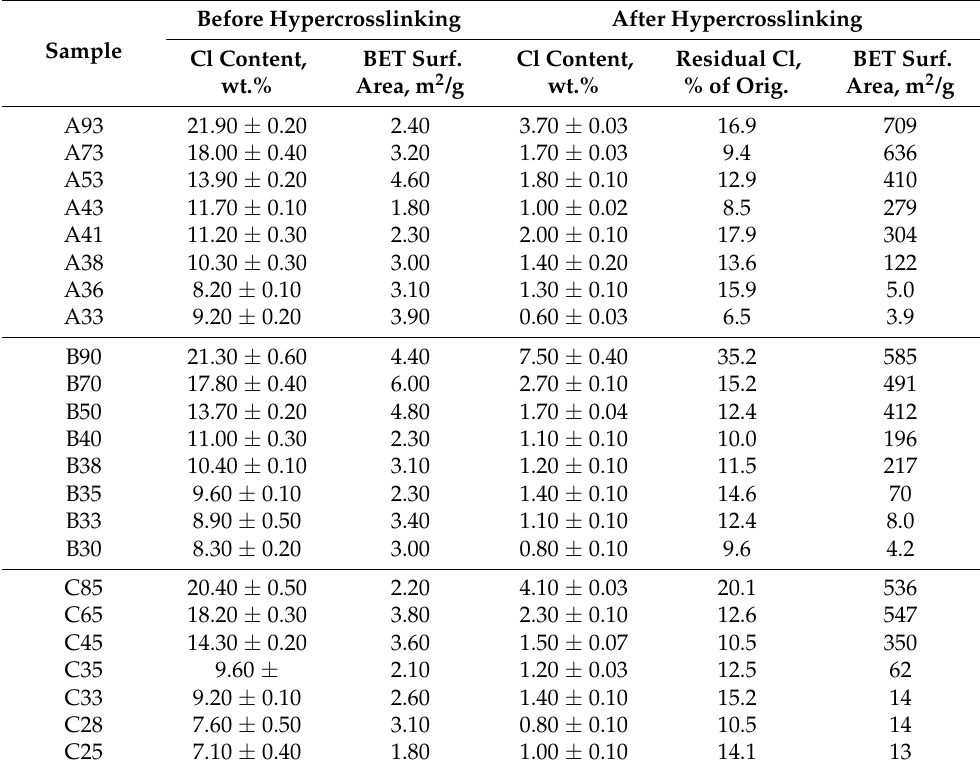
Table 2. Hypercrosslinking effects.